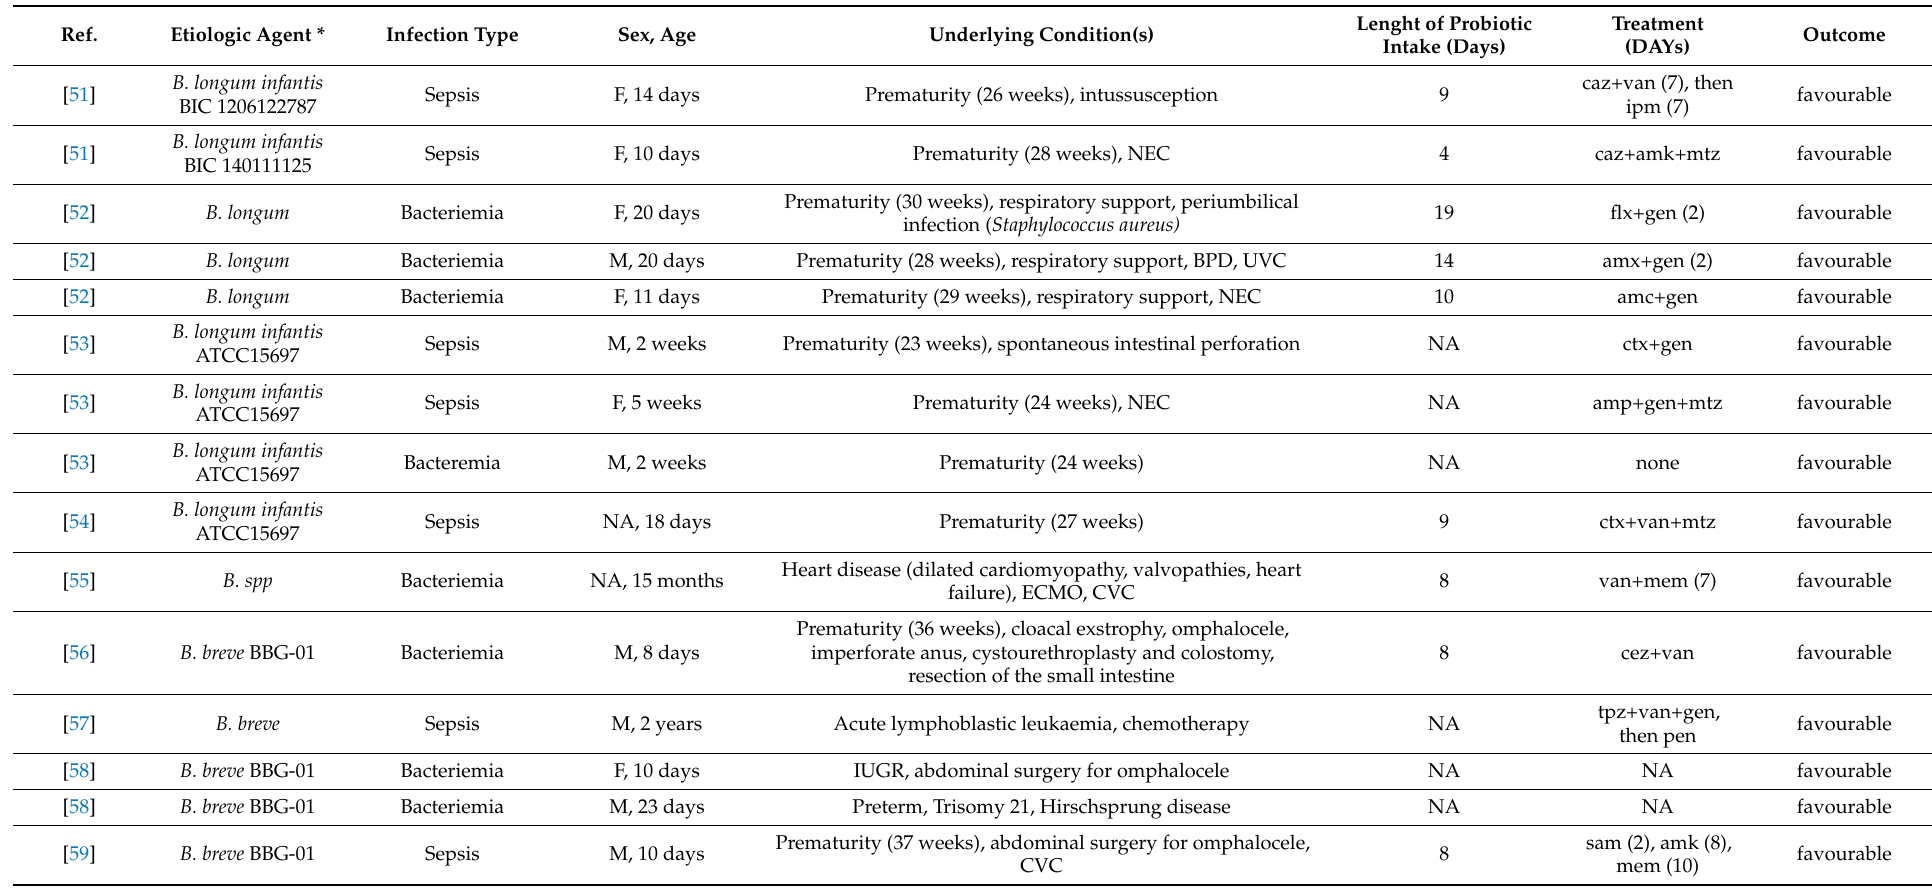
Table 3. Clinical and microbiologic features of 15 paediatric patients with Bifidobacterium spp. ( B. spp.) invasive infections after use of probiotics.